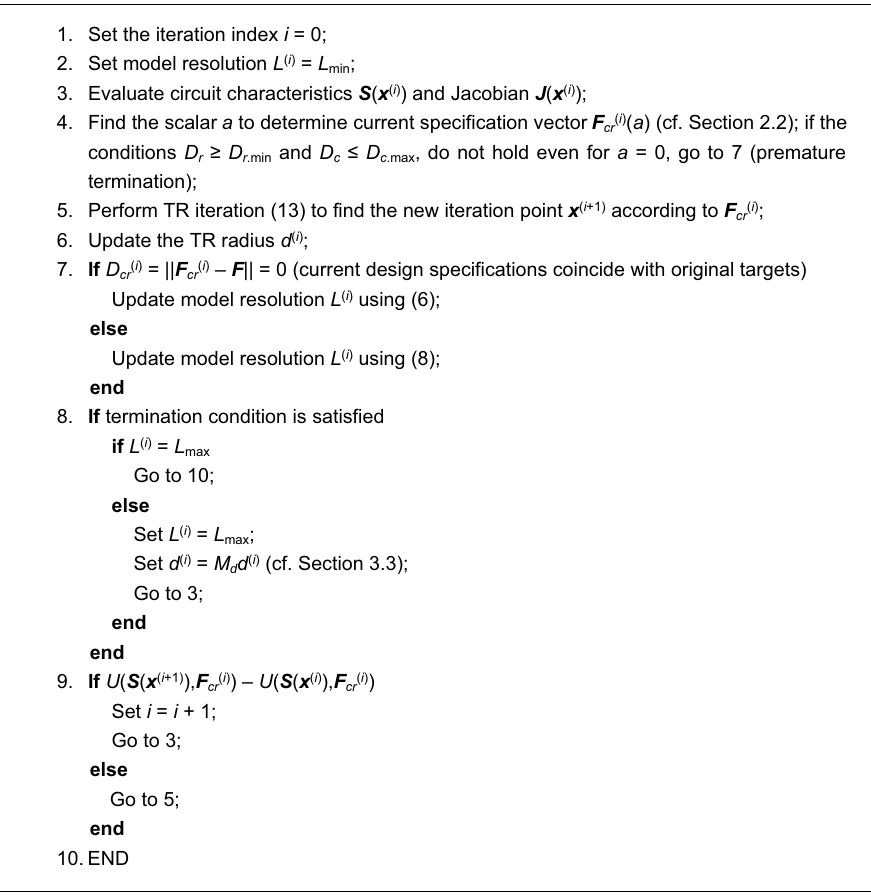
Figure 4. Pseudocode of the proposed optimization algorithm with design requirement management and variable-fidelity EM